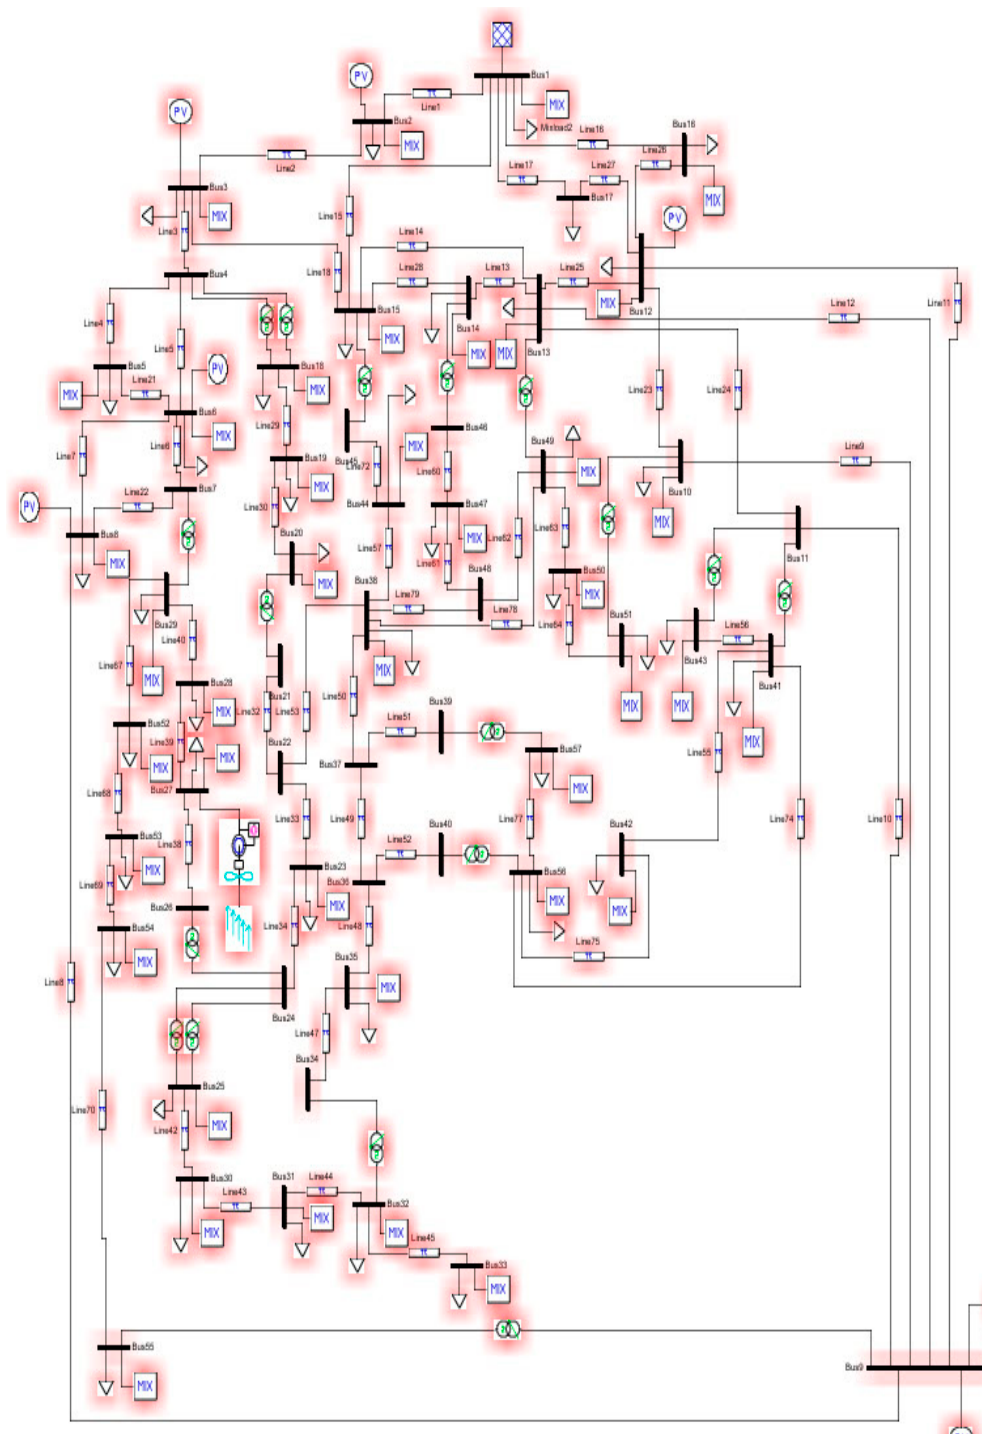
Figure 7. Simulation diagram of the IEEE 57 bus system model.